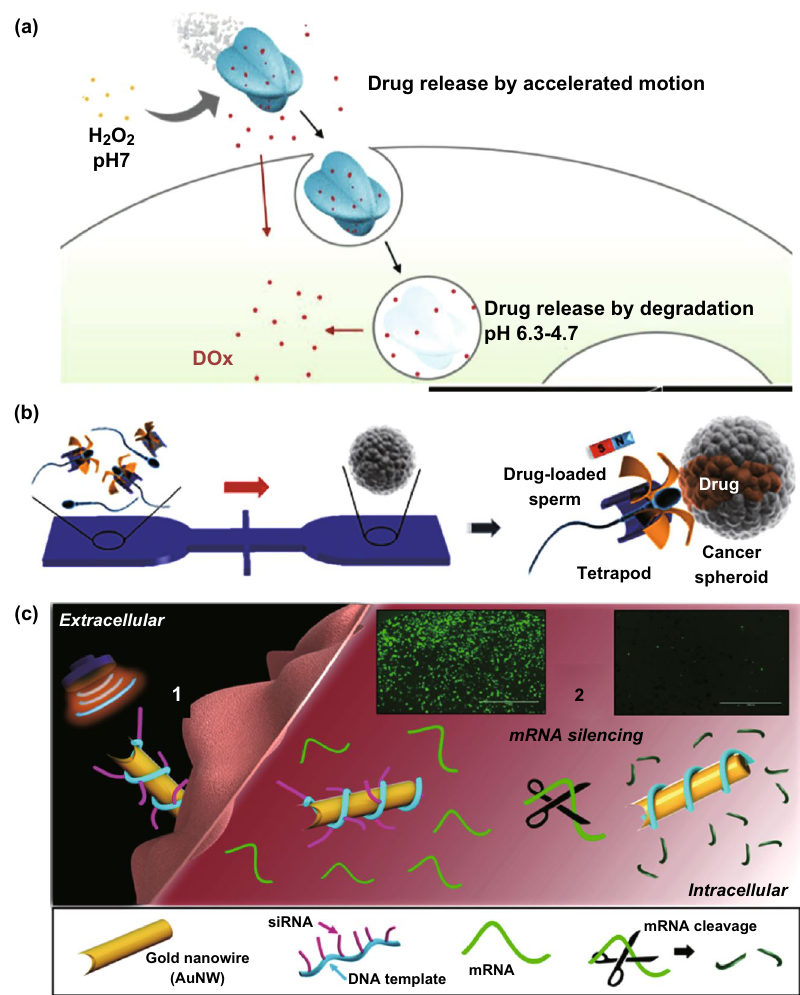
Fig. 3 a Superassembled biocatalytic porous framework micromotors (cat-β@ZIF) with reversible and sensitive pH-speed regulation for drug delivery. Adapted from Ref. [64] with permission, copyright Wiley Ltd., 2019. b Schematic of the microfluidic chip for drug-loaded sperm transport and delivery. Adapted from Ref. [65] with permission, copyright American Chemical Society, 2017. Notice: further permissions related to this material excerpted should be directed to the ACS. c Acoustically propelled nanomotors for intracellular siRNA delivery. Adapted from Ref. [66] with permission, copyright American Chemical Society,